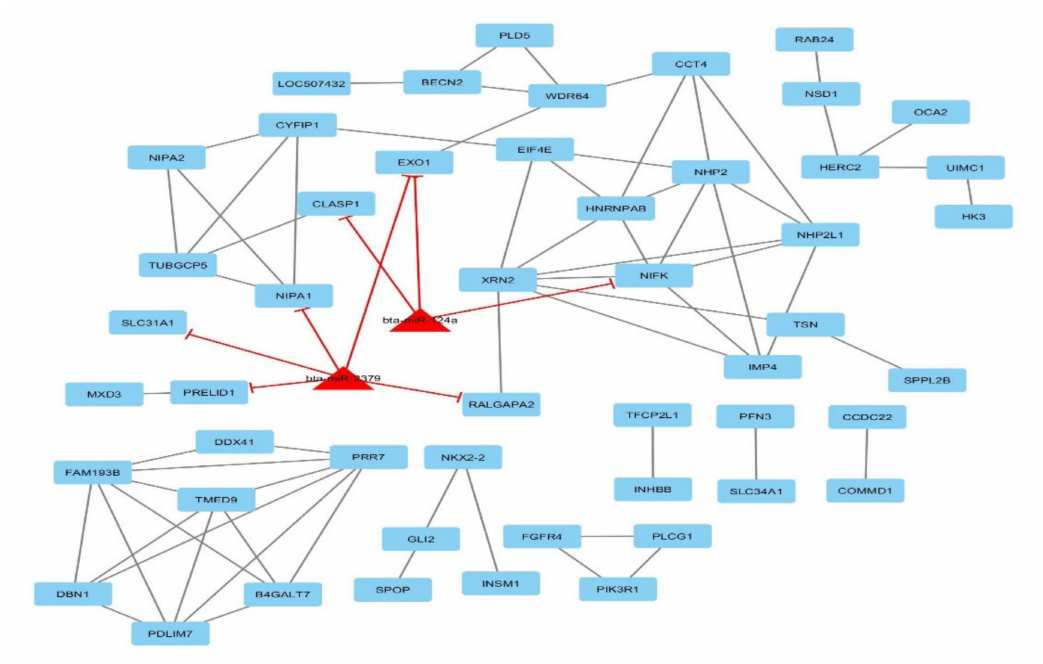
Figure 3. The network of backfat thickness related genes and miRNAs using Cytoscape software (version 3.7.2; www.cytoscape.org); each node denotes a gene (rectangle) and miRNA (triangle) and edges depict miRNA–gene